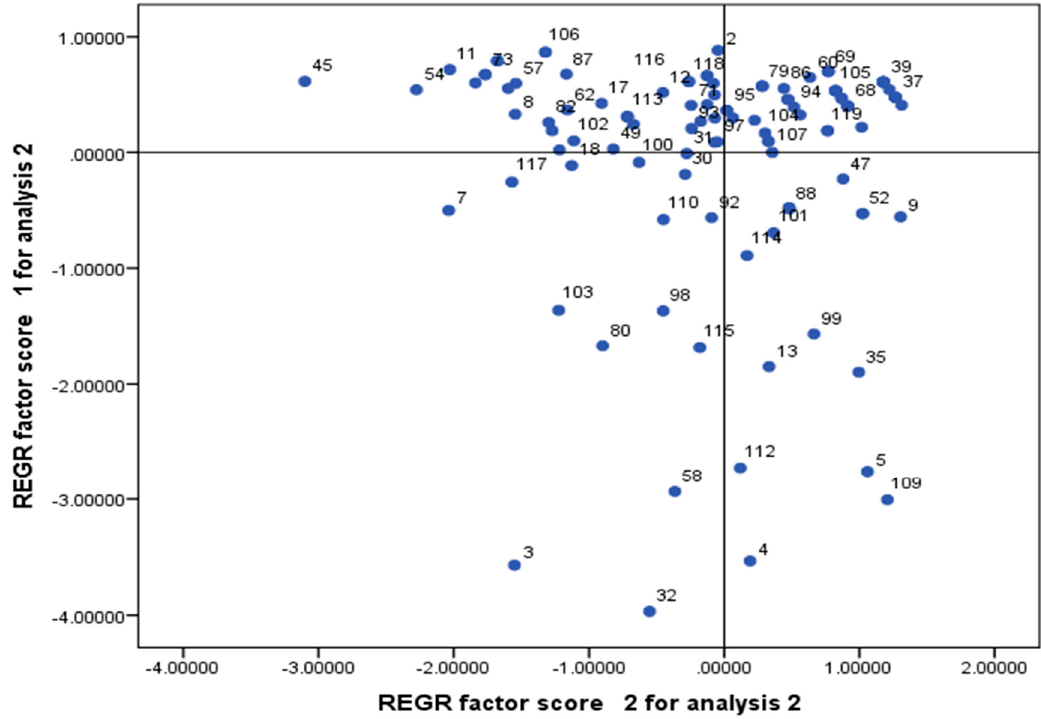
Figure 5. Scatter plot of regression (REGR) factor scores of households in Zango from the two PCA factors.